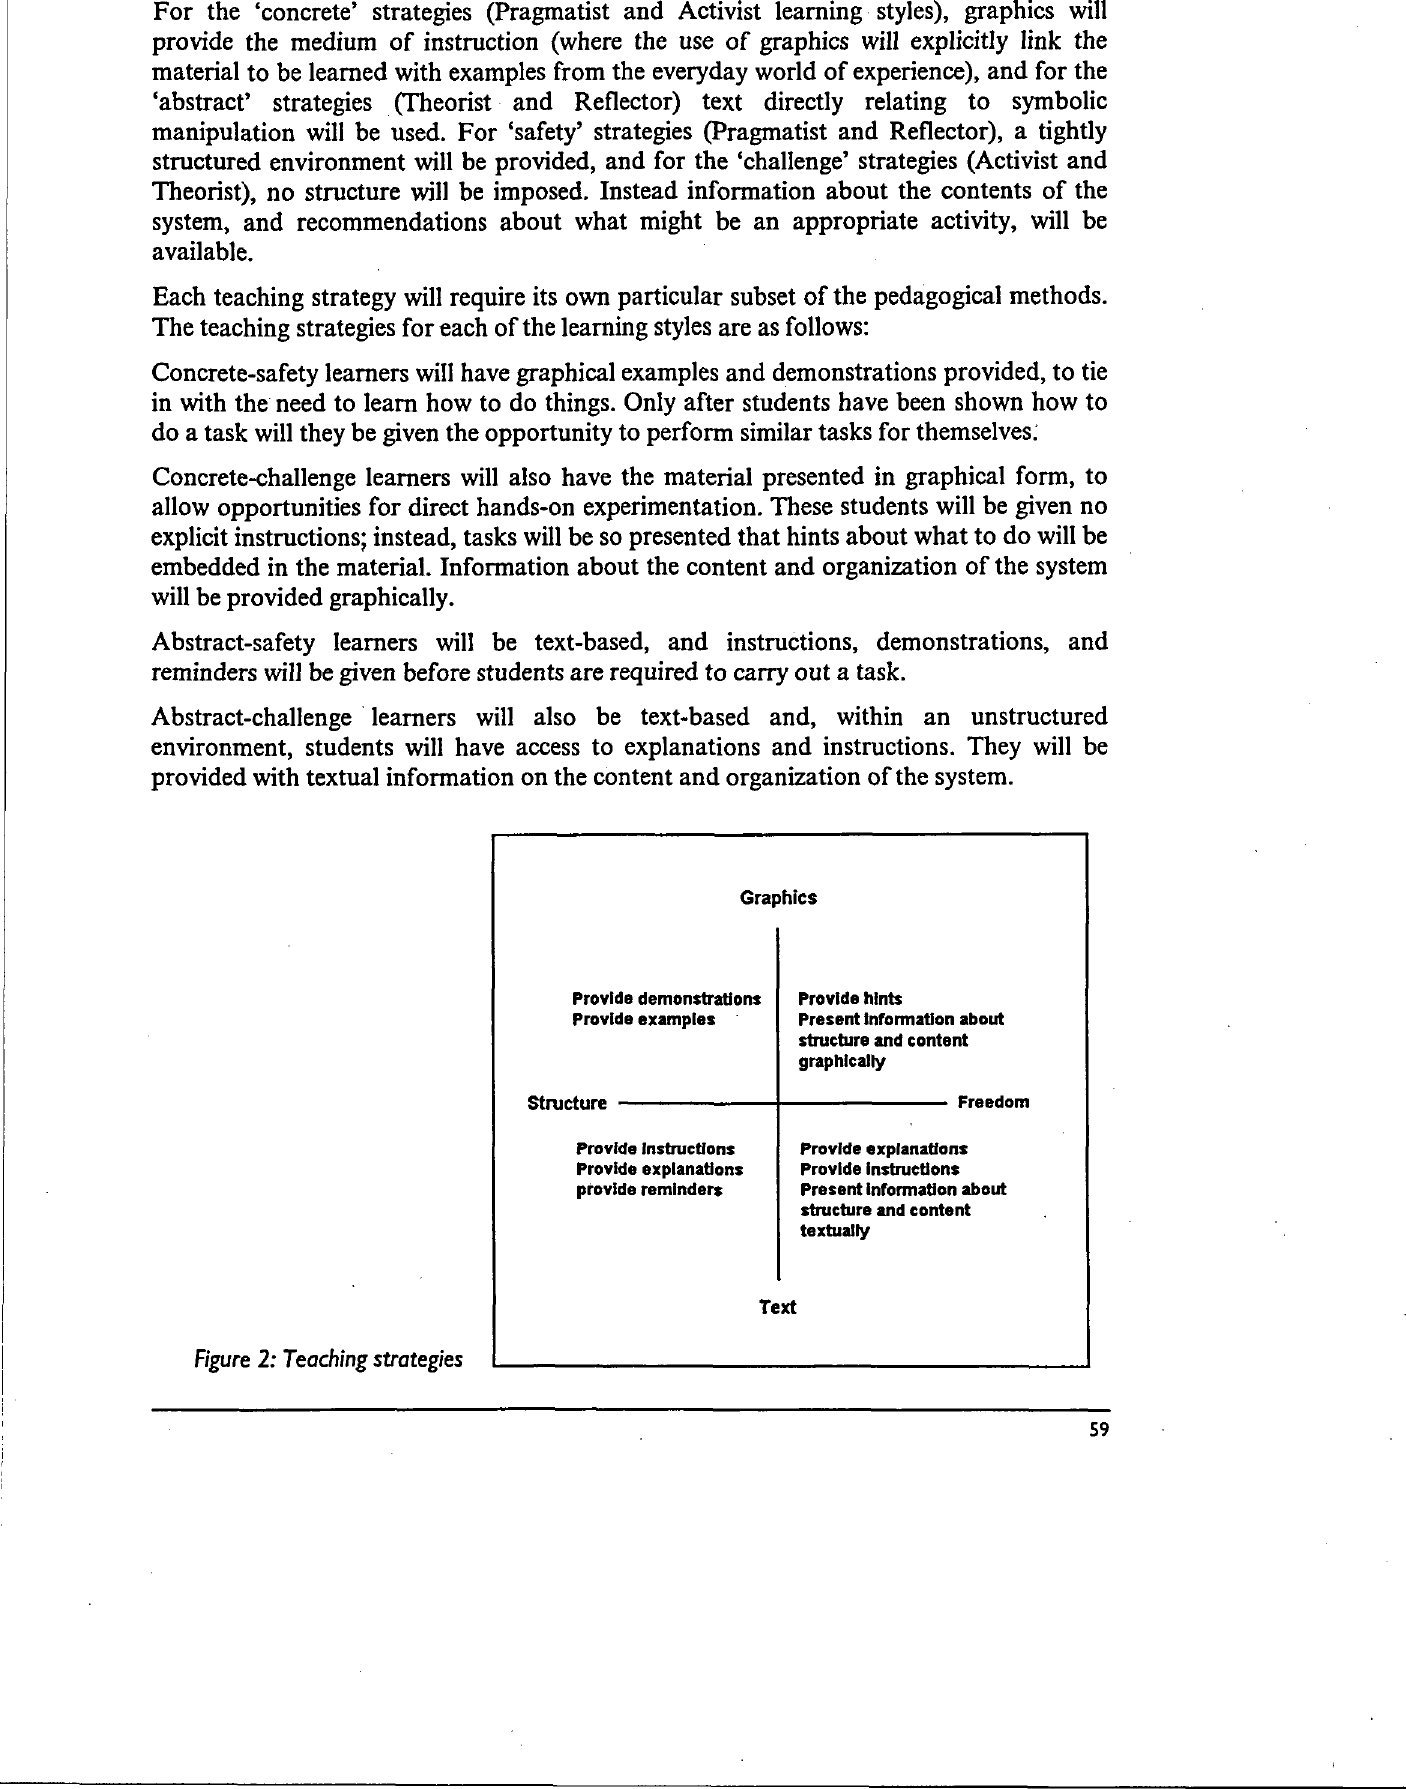
Figure 2: Teaching